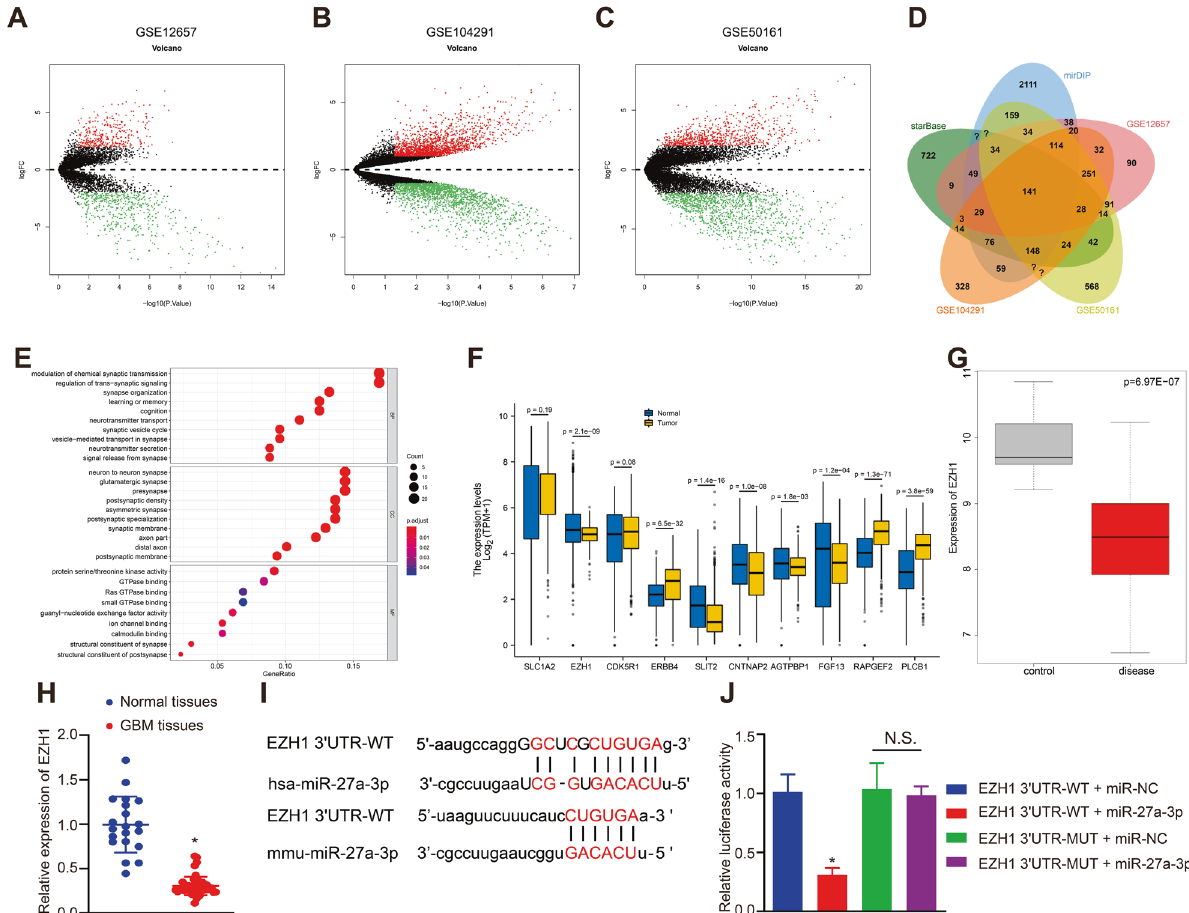
Fig. 3 hsa-miR-27a-3p targets EZH1. A Volcano plots displaying the differentially expressed genes retrieved from microarray dataset GSE12657. B Volcano plots displaying the differentially expressed genes retrieved from microarray dataset GSE104291. C Volcano plots displaying the differentially expressed genes retrieved from microarray dataset GSE50161. The X-axis represents -log10 ( p value), the Y-axis represents logFoldChange, red dots represent upregulated genes, and green dots indicate downregulated genes. D Venn diagram displaying the intersection of target genes of hsa-miR-27a-3p predicted by bioinformatics analysis and differentially expressed genes retrieved from microarray datasets GSE12657, GSE104291 and GSE50161. E GO functional enrichment analysis on the intersected genes. X-axis represents gene ratio. Y-axis represents GO entries. The right histogram is color gradation. F Expression level of candidate genes in TCGA_LGG and GTEx. G The expression of EZH1 in microarray GSE50161. H The expression of EZH1 in clinical samples of patients with GBM ( n = 50) and non-GBM patients ( n = 20), * p < 0.05 compared with normal tissues. I The binding sites between hsa-miR-27a-3p and EZH1 3 ’ UTR in human and mice predicted by starBase databse. J The targeting relationship between miR-27a and EZH1 veri fi ed by dual luciferase reporter gene assay, * p < 0.05 compared with EZH1 3 ’ UTR-WT + mimic-NC group. The experiment was repeated 3 times independently.